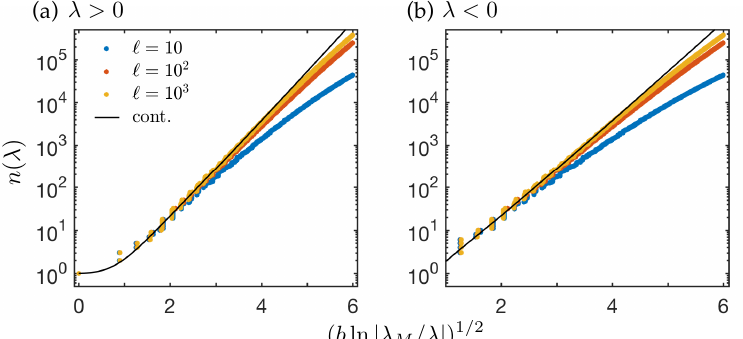
Figure 6: Tail distribution function for the spectrum of ρ (cid:101) T A of two equal adjacent in- tervals on an infinite chain. Solid lines are the analytical distributions from Eq. (97b). Dots are numerics, with different colors corresponding to different subsystem